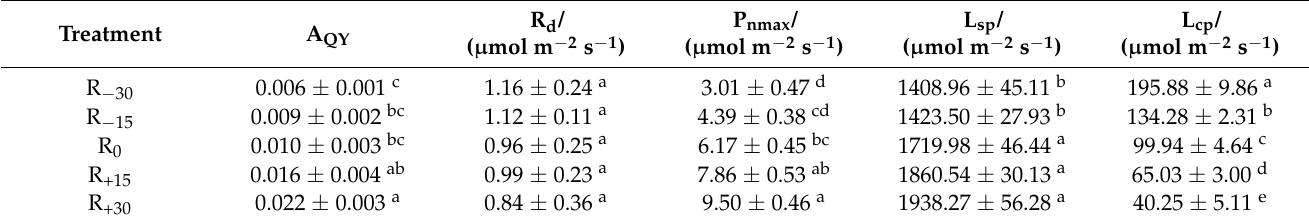
Table 2. Light response parameters of Gymnocarpos przewalskii leaves under different rainfall treatments.